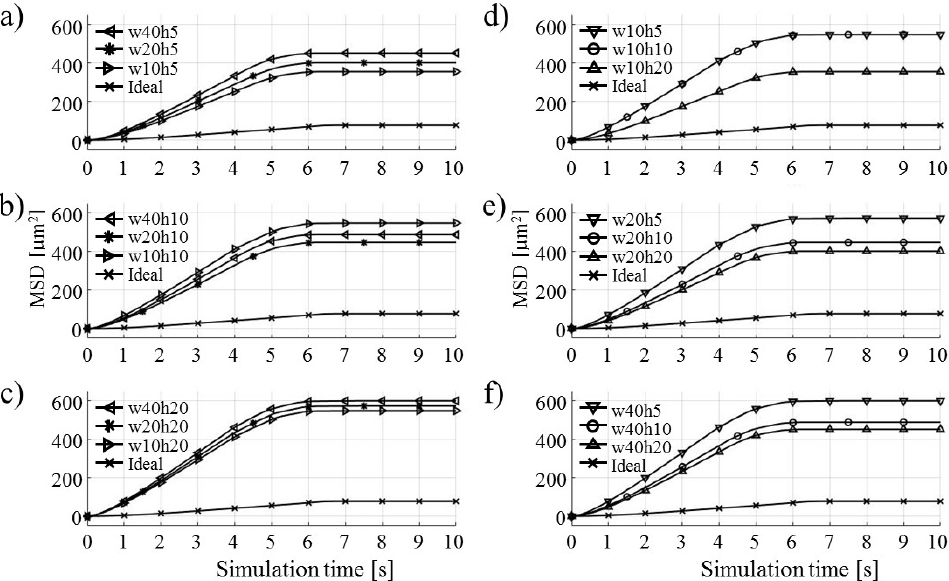
Figure 21. Computed MSD values for Pin electrode shape geometry variations: ( a – c ) varying width w only: 10, 20, 40 ( μ m); ( d – f ) varying height h only: 5, 10, 20 ( μ m).